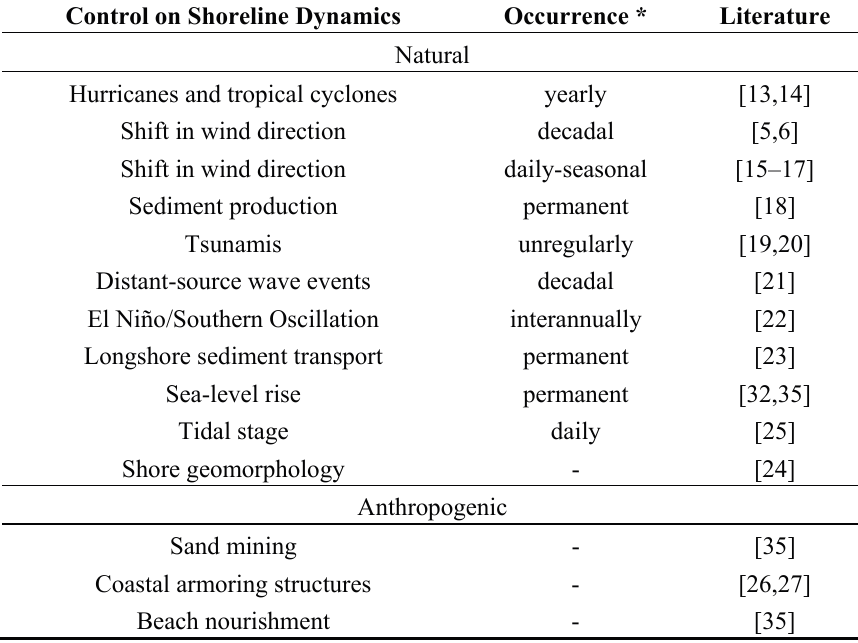
Table 1. Summary of the most important natural and anthropogenic influences on reef island shorelines as described in the